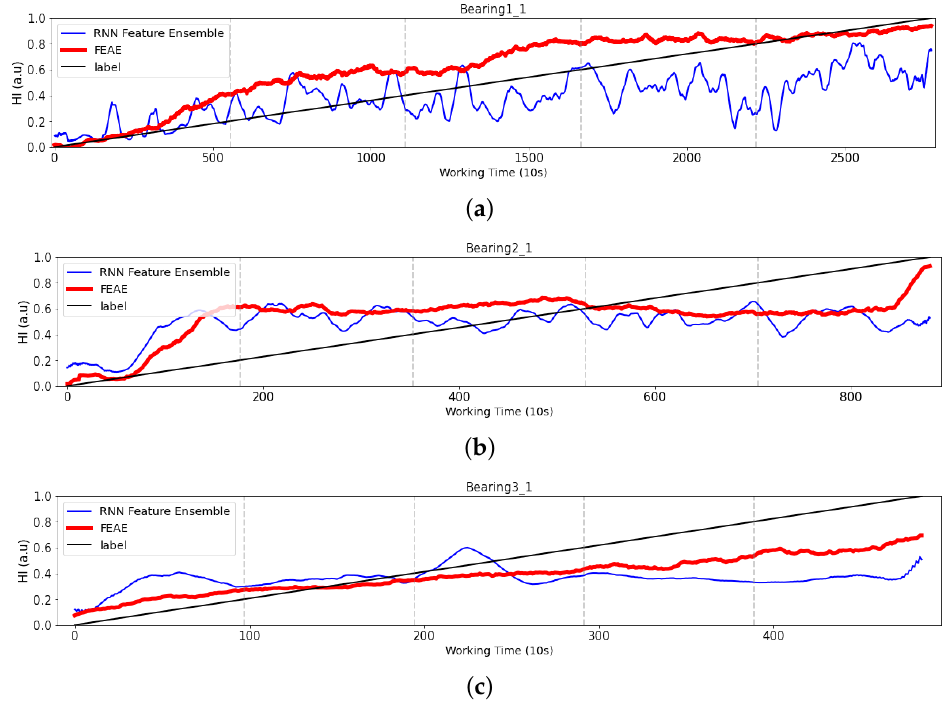
Figure 16. Comparison of experiment results of RNN type models. ( a ) Test bearing1_1, ( b ) Test bearing2_1, ( c ) Test